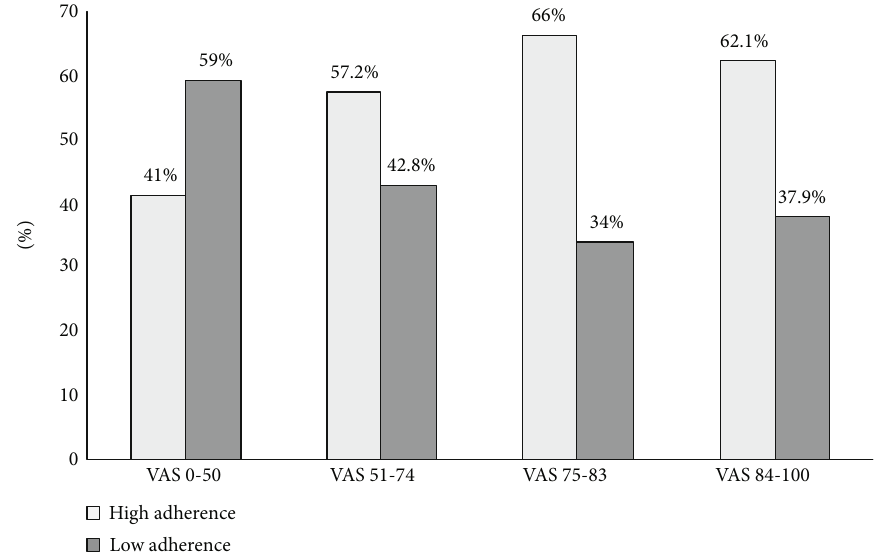
Figure 3: Distribution of patient ’ s EQ-VAS scores according to their Adherence level. Notes: light segments, high adherence; dark segments, low adherence. EQ-VAS scores are divided into quartiles: 1st quartile: 0 – 50; 2nd quartile: 51 – 74; 3rd quartile: 75 – 83; 4th quartile: 84 –